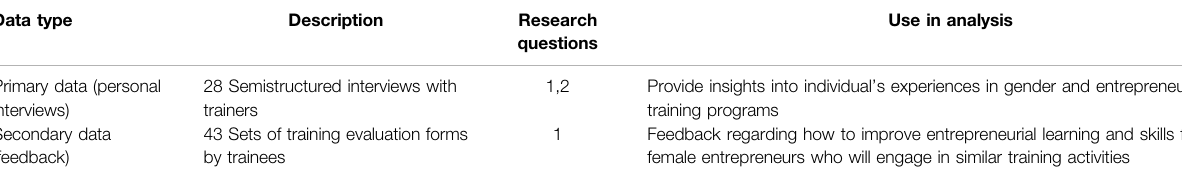
TABLE 2 | Description of